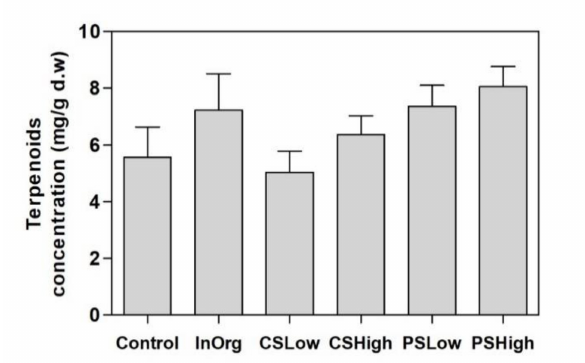
Figure 1. Total terpenoid leaf concentrations (mg g − 1 d.m.) in Rosmarinus o ffi cinalis plants in the various fertilization treatment groups: Control, InOrg, CS Low , CS High , PS Low and PS High . Vertical bars indicate standard errors of the mean ( n = 3).